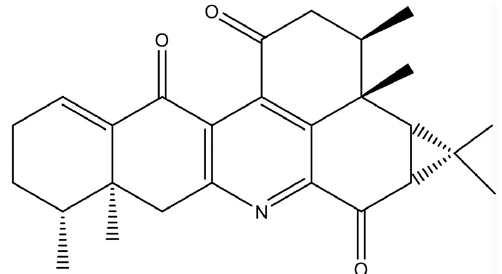
Figure 1. Chemical structure of nardochinoid B (NAB).